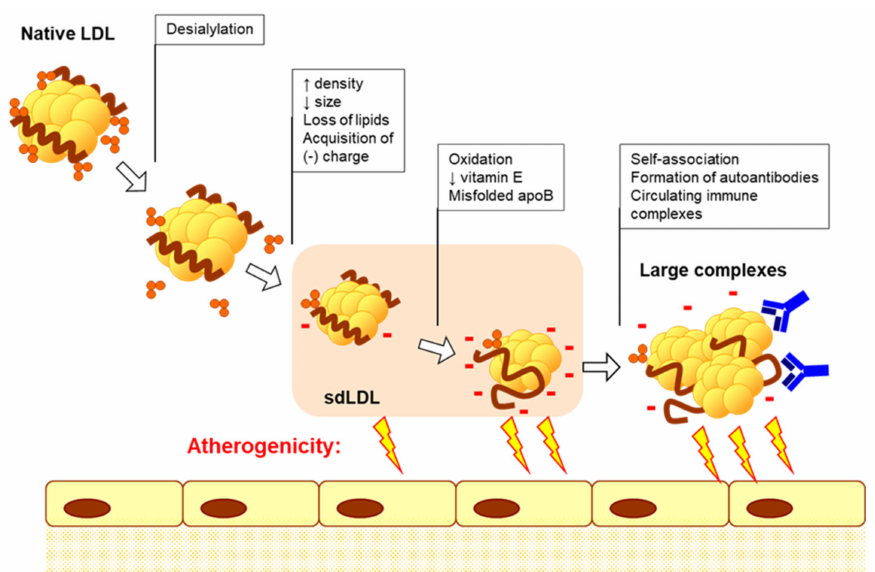
Figure 3. Cascade of multiple atherogenic modification of low-density lipoprotein (LDL). Multiple atherogenic modifications of LDL particles have been detected in human blood plasma: desialylation was the first event, followed by loss of free cholesterol and cholesterol esters, phospholipids and triglycerides, increase in particle density and decrease in its size; next, negative charge of particles was increased, leading to the formation of electronegative LDL fraction, in which misfolded apolipoprotein B (apoB) was reported; at later stages, increased oxidation and decreased antioxidant content were observed; finally, large highly atherogenic complexes can be formed due to self-association of modified LDL particles and the formation of